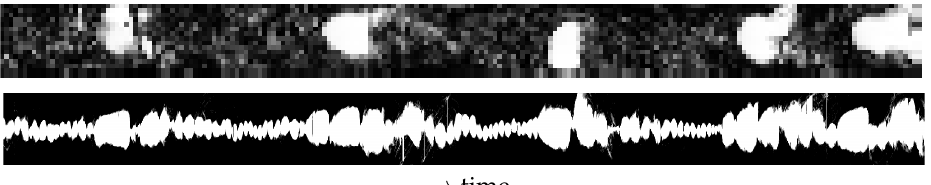
Figure 19. Flow reconstruction of wire-mesh sensor ( top ) and camera ( bottom ) synchronized by the delay of Figure 18 for a liquid flow rate of 80 L/min and a gas flow rate of 70 L/min. The top image shows the passage of large gas pockets (in white) with several small bubbles in between (gray pixels), and the bottom image shows sections of wide and thin core sections. The images together show the transformation of small bubbles upstream of the swirl element into regions of a thin gas core and the transformation of large gas pockets into regions of a wide gas